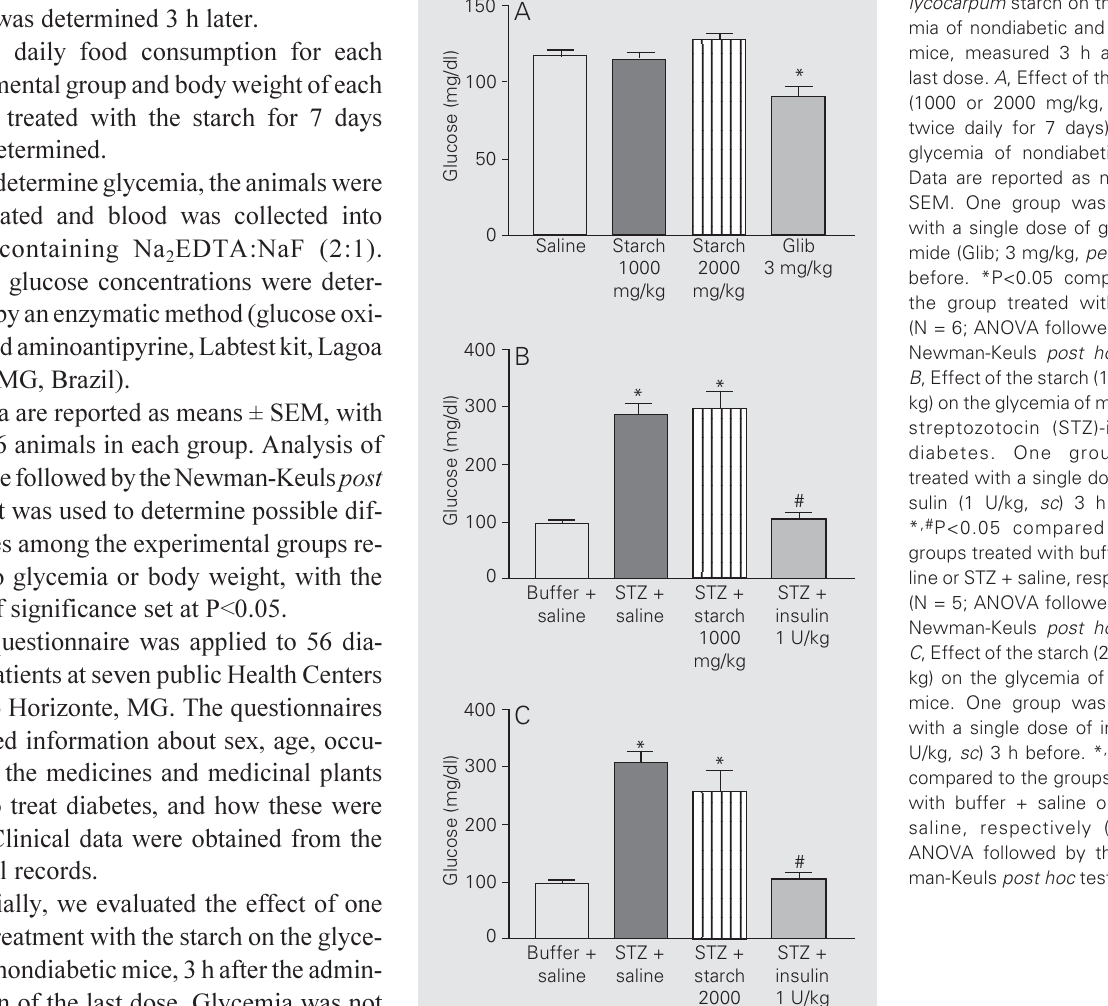
Figure 1. Effect of Solanum lycocarpum starch on the glyce- mia of nondiabetic and diabetic mice, measured 3 h after the last dose. A , Effect of the starch (1000 or 2000 mg/kg, per os , twice daily for 7 days) on the glycemia of nondiabetic mice. Data are reported as means ± SEM. One group was treated with a single dose of glibencla- mide (Glib; 3 mg/kg, per os ) 3 h before. *P<0.05 compared